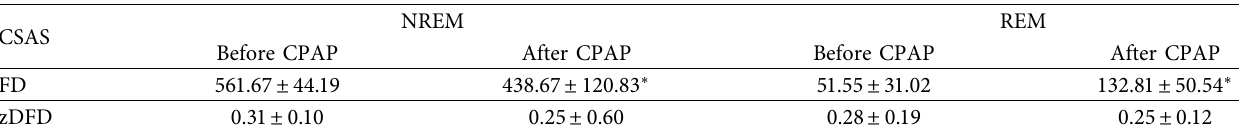
Table 3: The data of FD and zDFD before and after continuous positive airway pressure (CPAP) treatment in patients with central sleep apnea syndrome